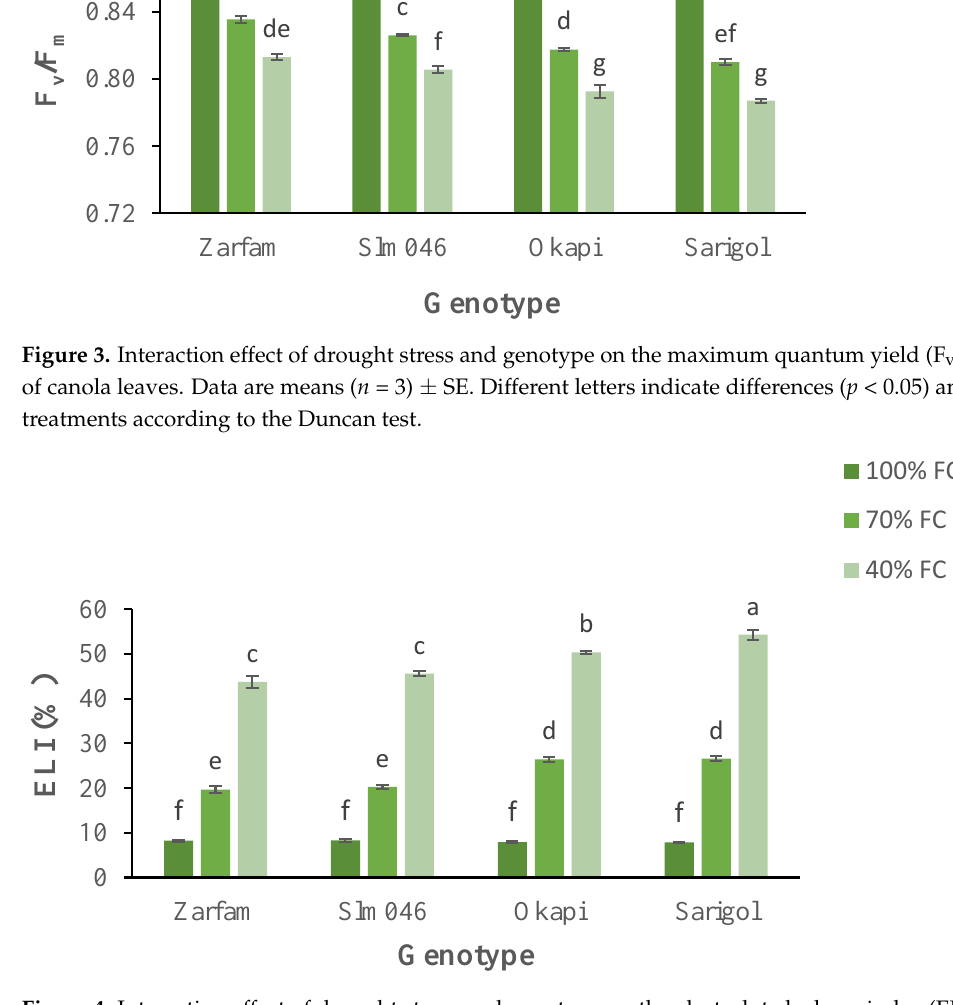
Figure 4. Interaction effect of drought stress and genotype on the electrolyte leakage index (ELI) of canola leaves. Data are means ( n = 3) ± SE. Different letters indicate differences ( p < 0.05) among treatments according to the Duncan test.